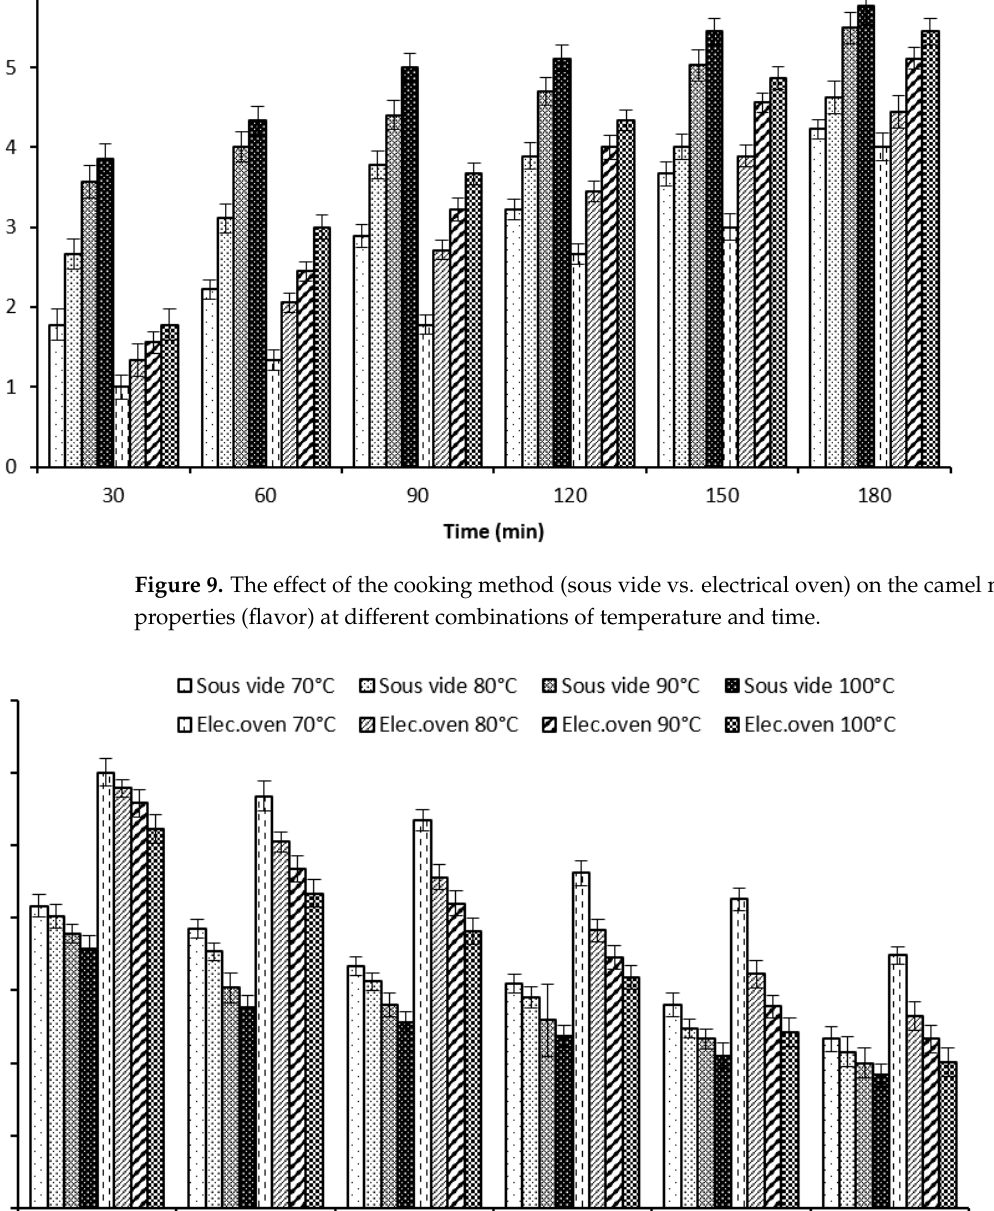
Figure 10. The effect of the cooking method (sous vide vs. electrical oven) on the camel meat sensory properties (juiciness) at different combinations of temperature and time.